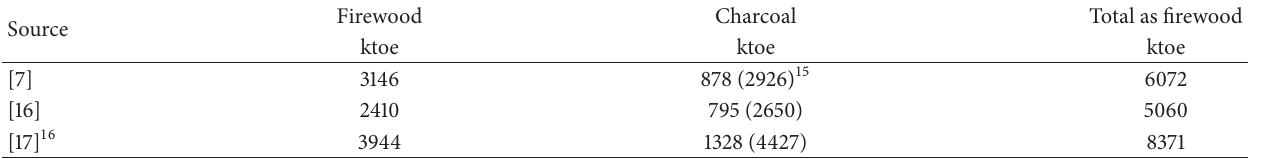
Table 21: Estimate firewood and